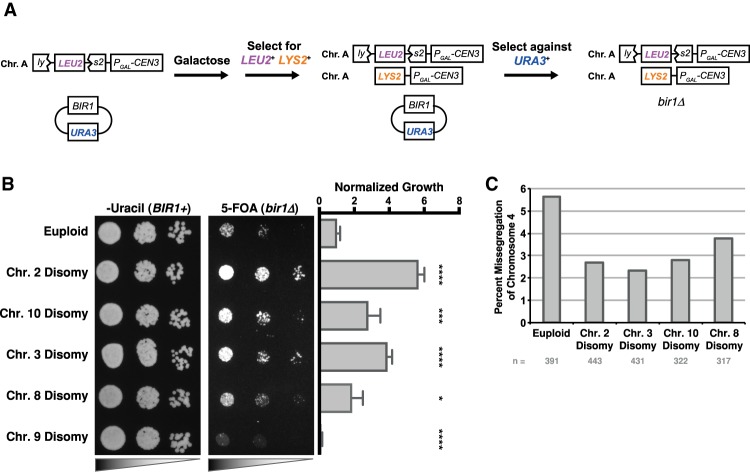
Disomy of specific chromosomes provides an initial advantage to BIR1 deletion. (A) Schematic of a galactose-inducible system to engineer disomy of specific chromosomes prior to BIR1 deletion. Strains transformed with a construct (PGALCEN3 lys2::LEU2) and a minichromosome containing BIR1 and URA3 were grown in medium containing galactose to induce chromosome nondisjunction during cell division. Disomy of the desired chromosome was then selected for on minimal medium plates lacking leucine and lysine. Disomic strains for the chromosome of interest were grown on plates containing the drug 5-FOA to select for loss of the URA3 gene, creating bir1Δ yeast that are disomic for the chromosome of interest. (B) Tenfold dilution series of disomic strains on minimal medium plates with 5-FOA (selecting against URA3) or lacking uracil (selecting for URA3) plates. The graph shows the quantification of the growth of each strain after selection against BIR1 with 5-FOA. All values were normalized to the initially euploid strain. (*) P ≤ 0.05; (***) P ≤ 0.0001; (****) P ≤ 0.00001, unpaired t-test. (C) Missegregation rates of GFP-labeled chromosome 4 for bir1Δ strains from 5-FOA plates as in B. The total numbers of quantified segregation events (n) are indicated below the graph. See Supplemental Figure S1A for examples of segregation and missegregation events.